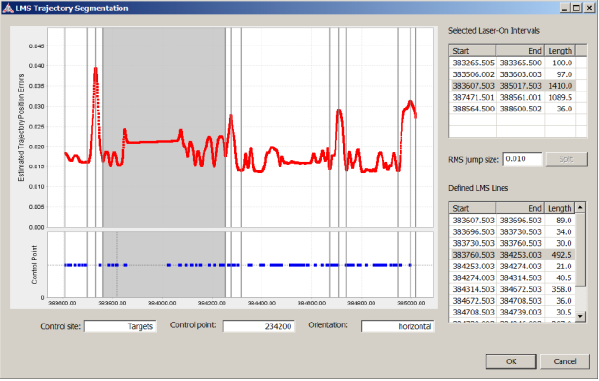
Figure 2. Trajectory segmentation based on position accuracy.